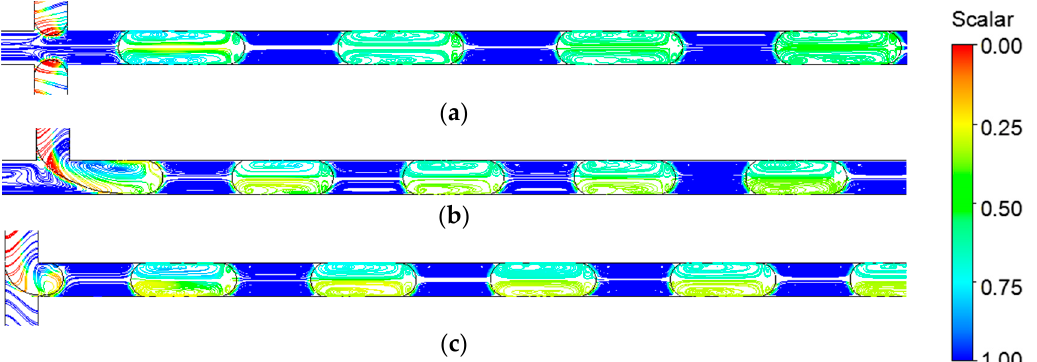
Figure 10. Scalar distribution in droplet moving stage. u total = 50 mm/s, ε d = 0.5. ( a ) Cross-shaped junction; ( b ) Cross-shaped T-junction; ( c ) T-junction.